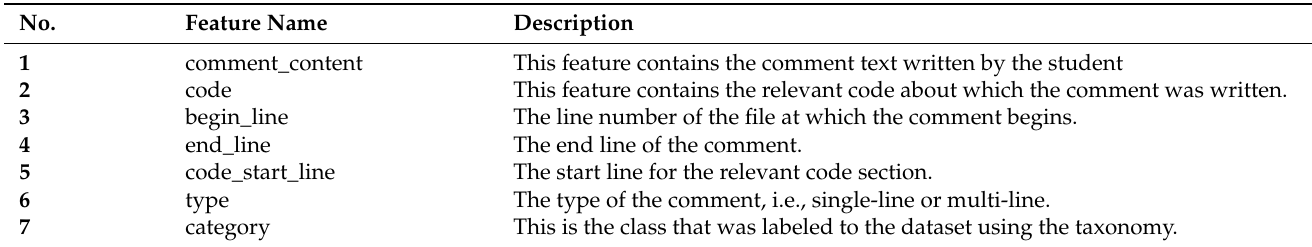
Table 3. Description of the features extracted for the dataset